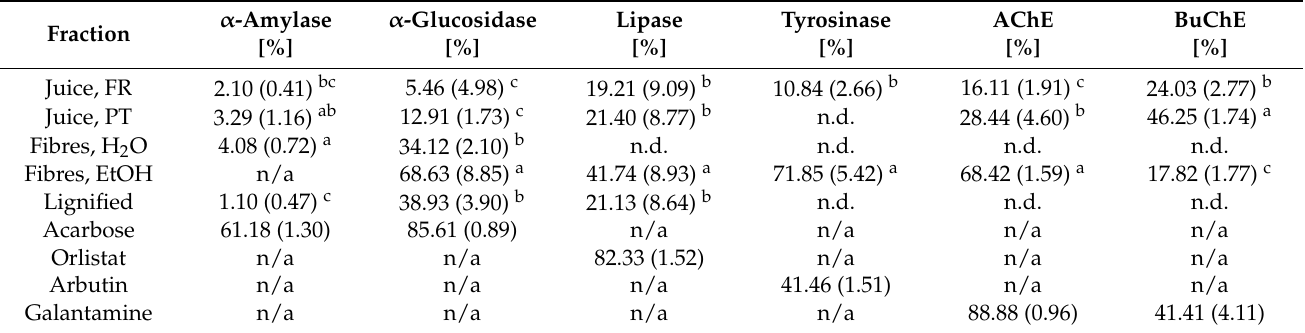
Table 4. Enzyme inhibition activity [%] of reference compounds and 10 mg/mL S. ramosissima stock solutions in relation to blank samples. n.d.: not detected or activity lower than the limit of detection, n/a: not available. Reference compounds were tested with 1 mg/mL, except acarbose (10 mg/mL). Results are mean values with standard deviations (in brackets). Different letters denote significantly different results, calculated individually for the results from each enzyme assay. For all assays ( p < 0.001), except for lipase inhibition assay ( p =